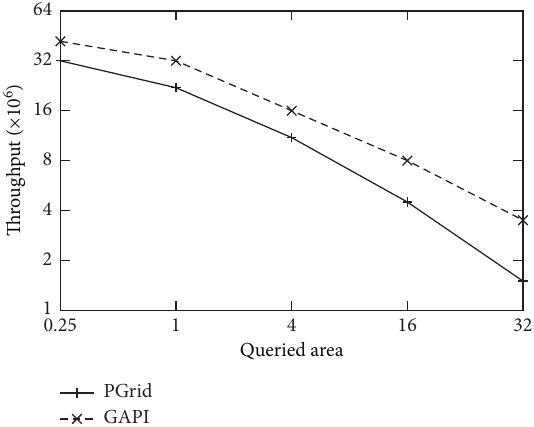
Figure 4: The effect of throughput on the size of the queried